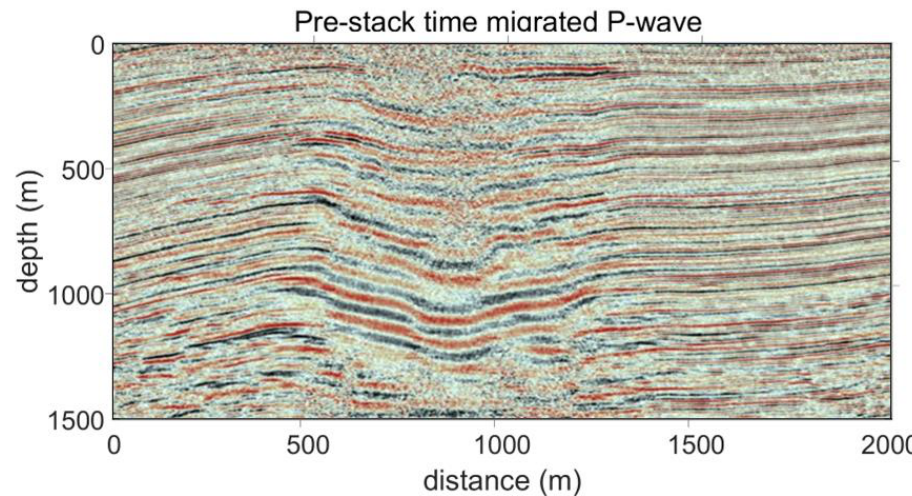
Figure 1. Pre-stack time migrated P-wave seismic section in a gas-cloud region of Sanhu.